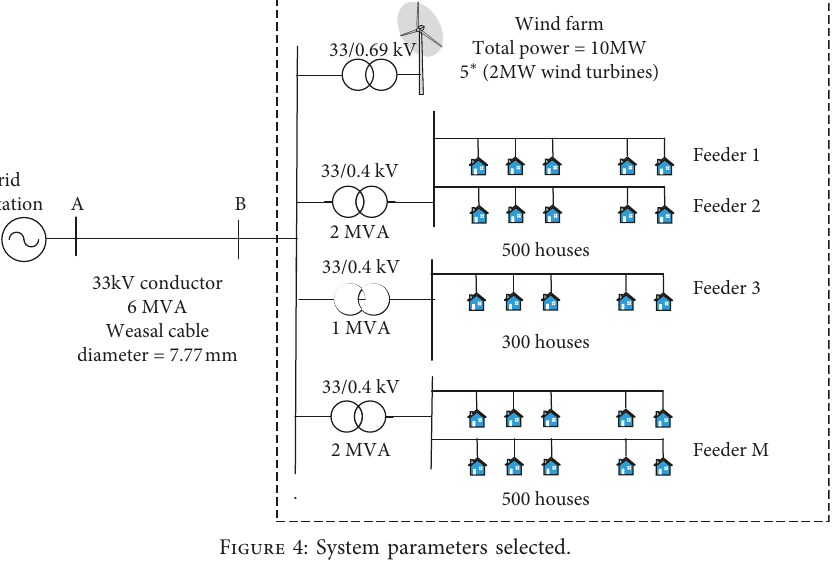
Figure 4: System parameters selected.